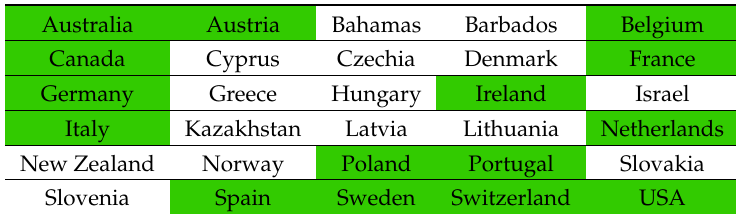
Table 1. Countries on high risk of death cluster. In green, we can see the countries that also appear in the Top 30 of countries with more deaths at the end of May 2020 based on COVID-19 Dashboard by the Center for Systems Science and Engineering (CSSE) at Johns Hopkins